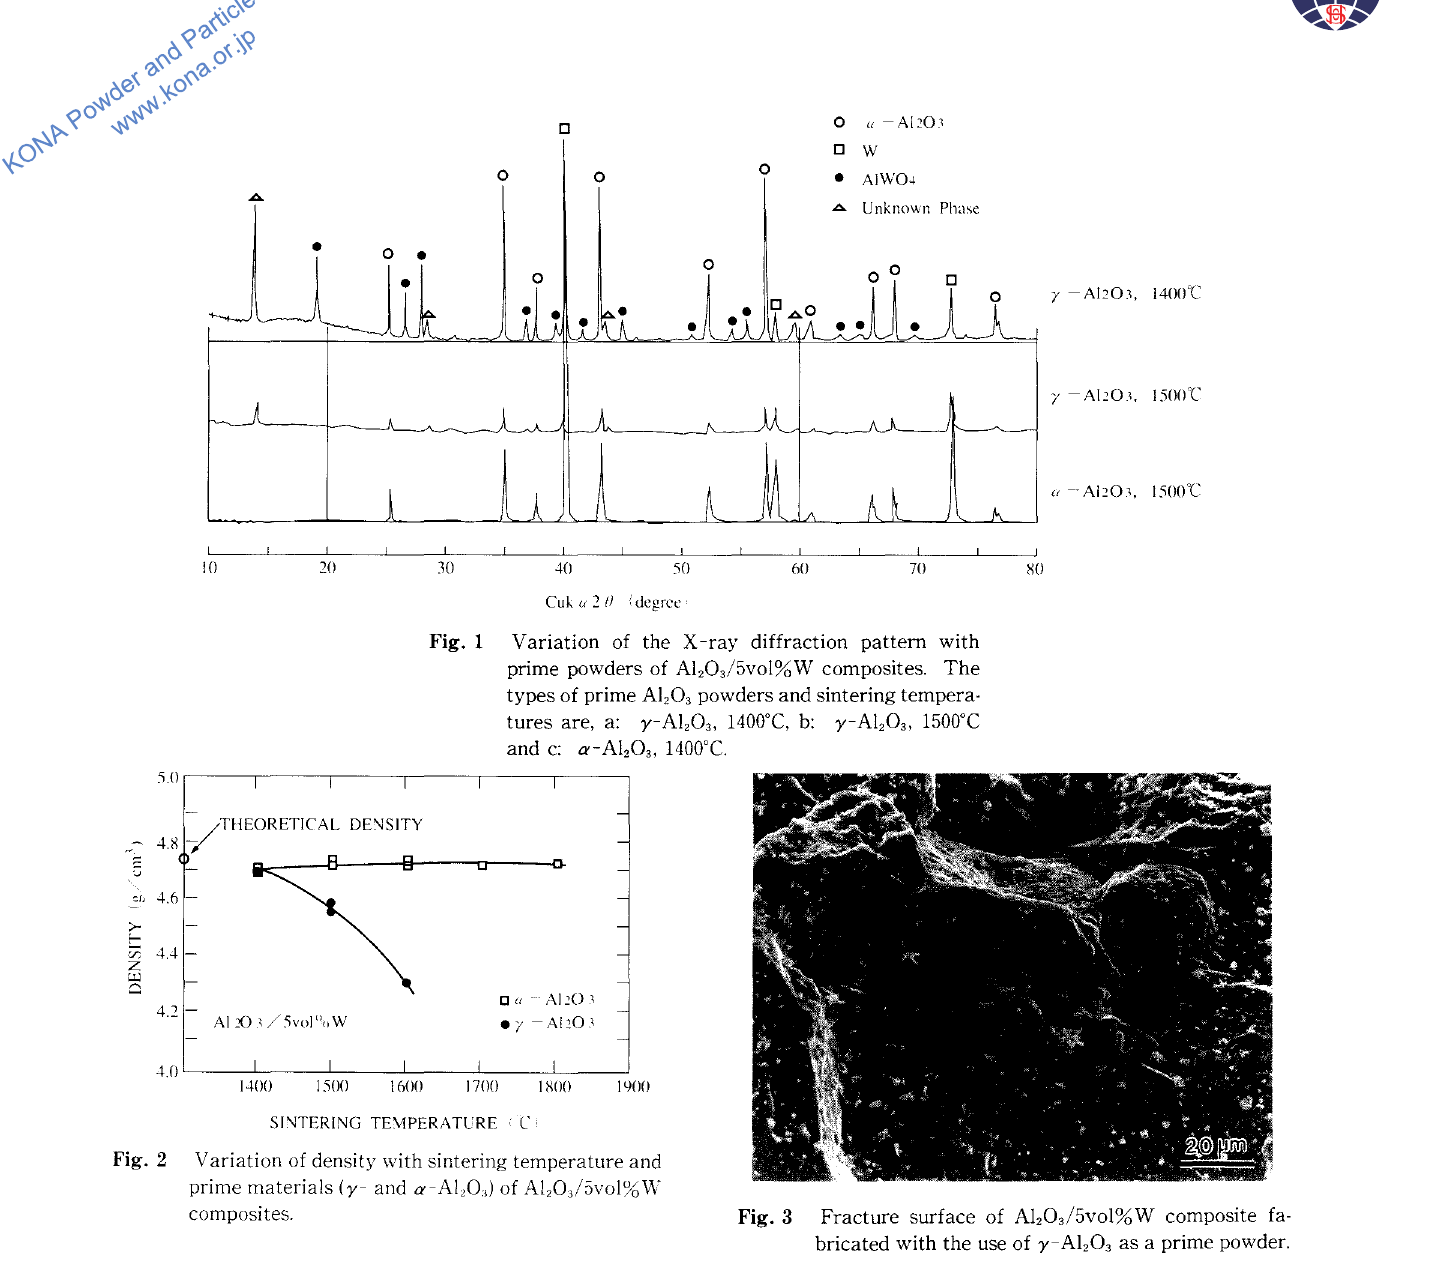
Fig. 2 Variation of density with sintering temperature and prime materials (y- and a-Al,OJ of Al,O,/Svol%W composites. Fig. 3 Fracture surface of Al